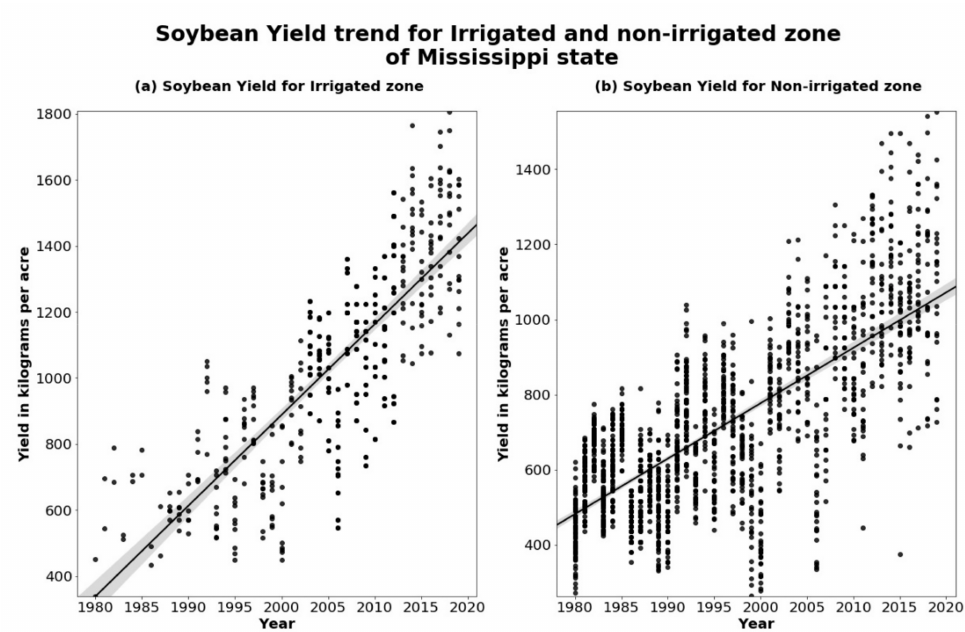
Figure 6. Trends for seasonal soybean yield change for ( a ) irrigated zones and ( b ) non–irrigated zones of the Mississippi State from 1980 to